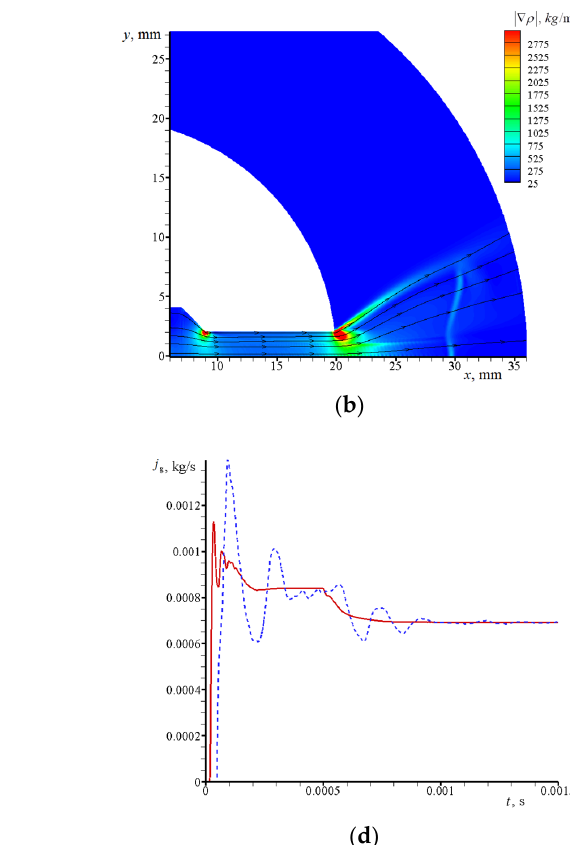
Figure 8. Calculated data for a two-phase gas–particle jet exhausting from a channel into a slotted space with h = 0.2 mm: ( a ) Mach-number isolines and gas-flow streamlines; ( b ) isolines of density gradient |∇ ρ | ; ( c ) particle concentration; ( d ) dependence of the gas flow rate at the channel inlet (solid line) and at the slot ‐ space outlet (dashed line) on time.